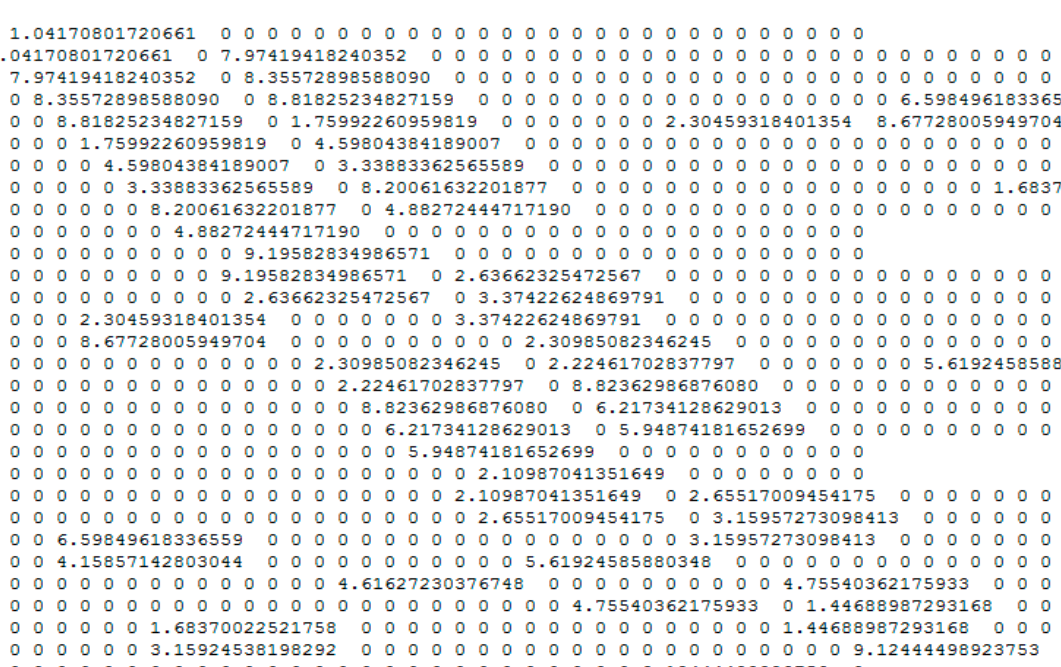
Figure 8. Simulated bus network connection diagram.